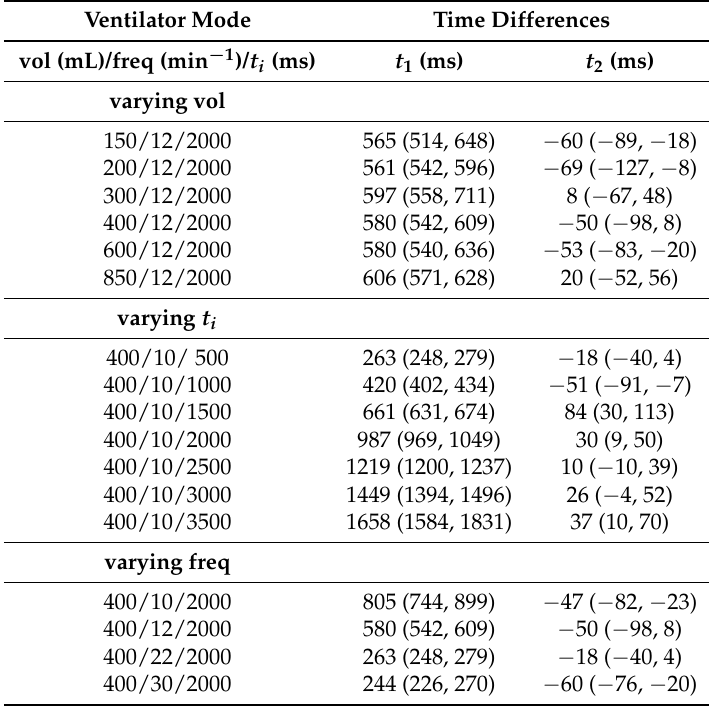
Table 1. Median time differences between Paw EO and TTI peak ( t 1 = t Paw TTI maximum downslope point ( t 2 = t Paw shown as median and 95% confidence intervals.